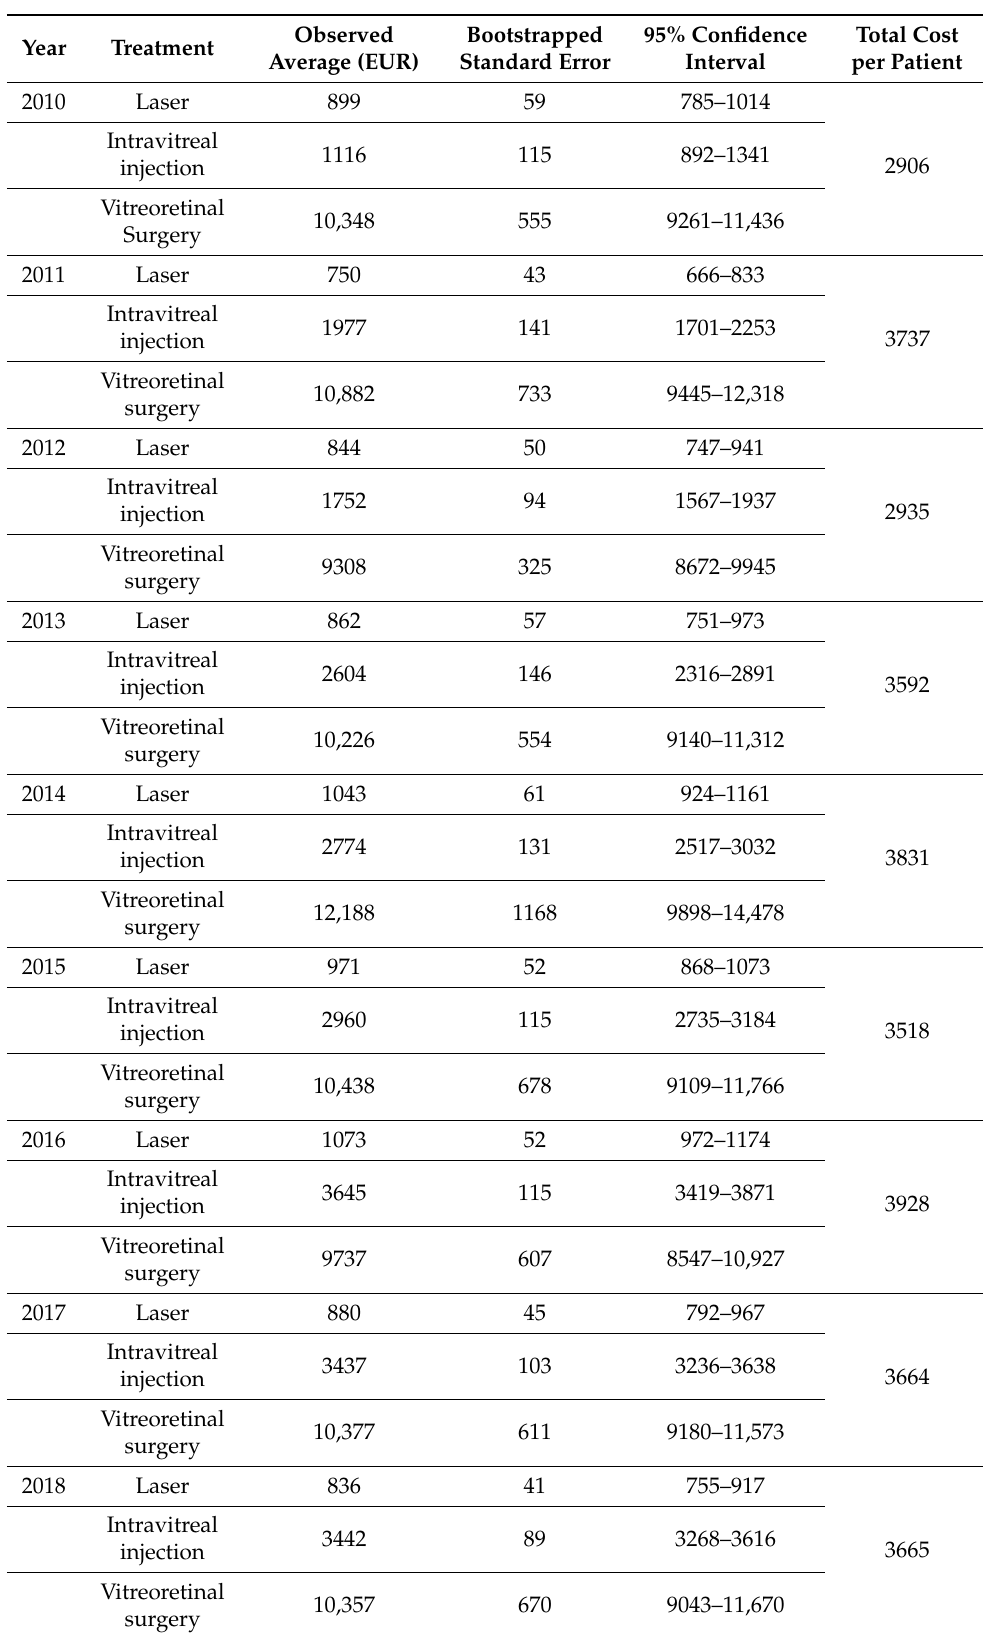
Table 3. Average costs per patient per year in each treatment